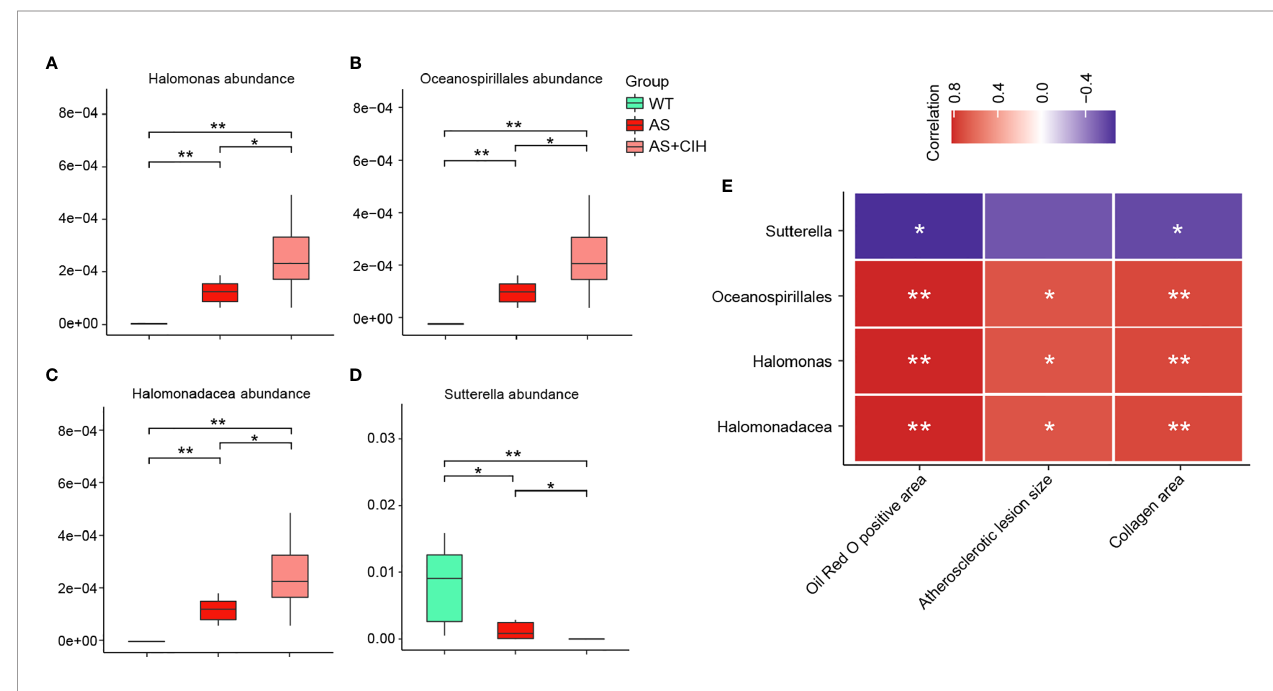
FIGURE 5 | Correlation of pathological changes in artery with the speci fi c gut bacteria further affected by CIH in AS mice. (A – D) Box plots showing relative abundance of speci fi c bacteria signi fi cantly altered in AS mice and further in fl uenced by CIH. The boxes represent the inter quartile ranges, whereas the inside line represent the median and the points are outliers. * P value < 0.05, ** P value < 0.01, Kruskal-Wallis. (E) Correlation analysis of Halomonas , Halomonadaceae , Oceanospirillales and Sutterella with parameters of pathological changes in artery, including Oil Red O positive area, atherosclerotic lesion size and collagen area. The thresholds derived from the Spearman correlation analyses were r ≥ 0.5 and P ≤ 0.05. * P value <0.05, ** P value